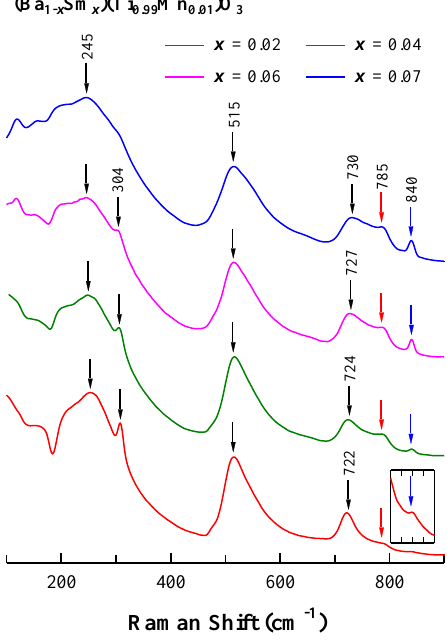
Figure 3. Raman spectra of BSTM ceramics excited by a 532 nm laser.